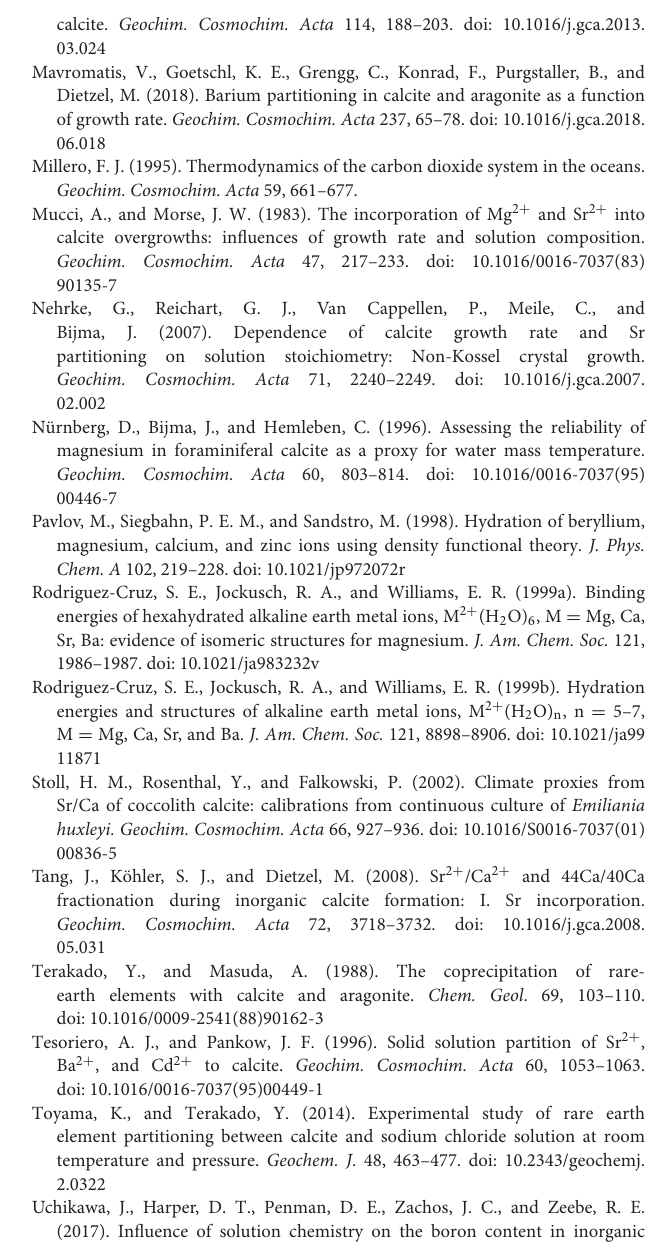
Table S1 | OVG-3 and OVG-3’ are two experiments; CF is a cleavage fragment; Pr is a profile. “ElapsedTime_s” can be converted to ablation rate via multiplying by 0.2